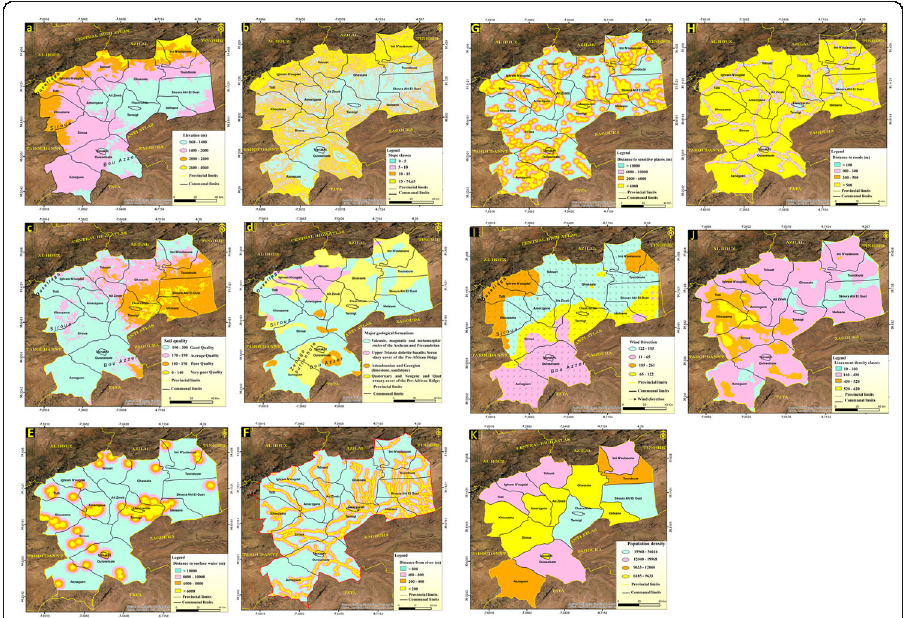
Fig. 10 Data reclassification maps. A Elevation. B Slope. C Soil quality. D Geology. E Distance to surface